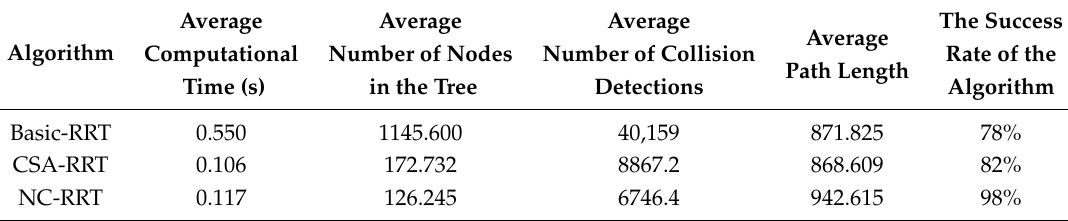
Table 3. Simulation results of the three algorithms in the narrow environment. ( k = 1, c = 2 ) .